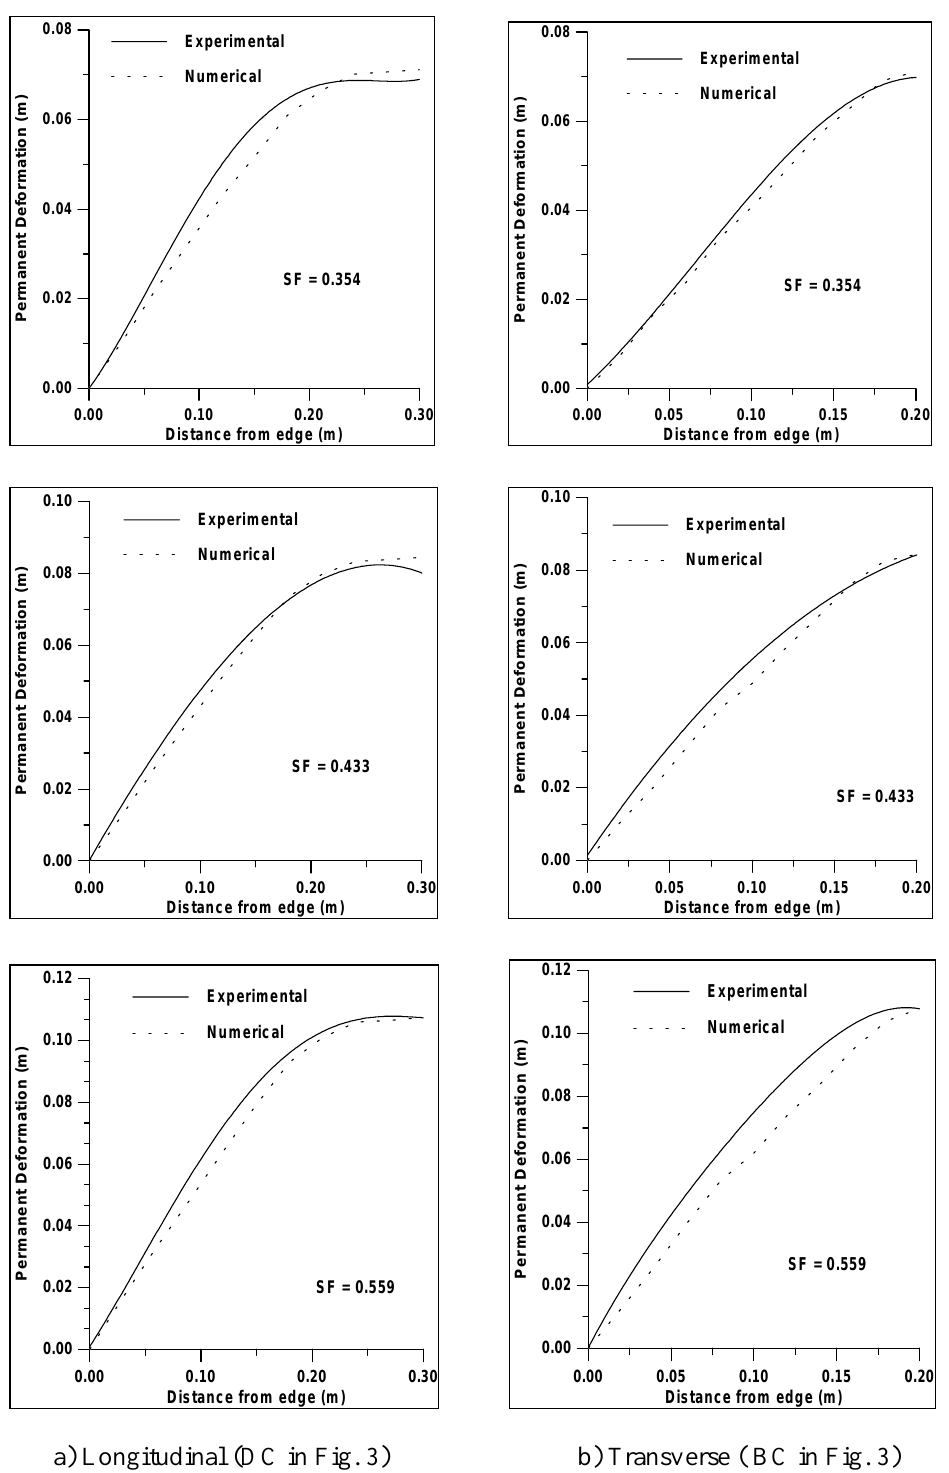
Fig. 15. Comparison of permanent deformation along center line ( h/l = 0 . 05